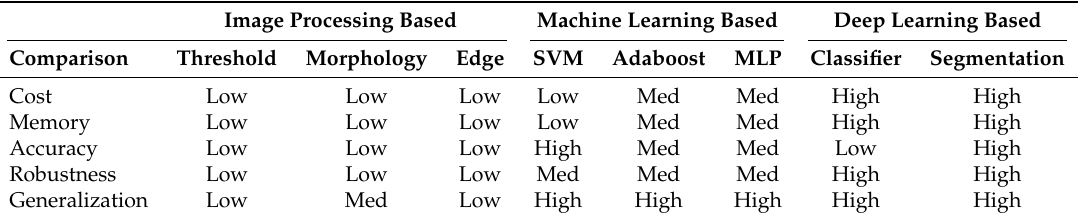
Table 1. Literature review of approaches for concrete crack detection and their advantages and shortcomings. Image Processing Based Machine Learning